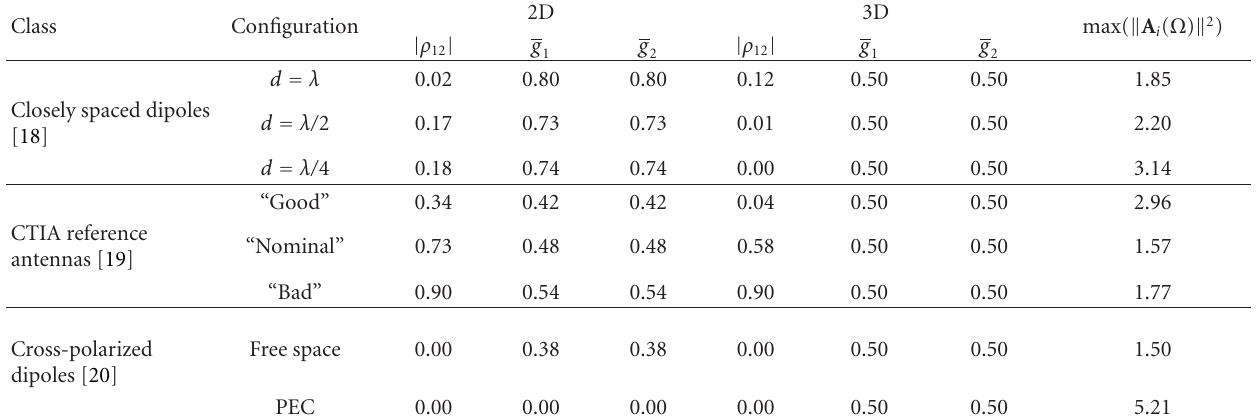
Table 1: Specified antenna